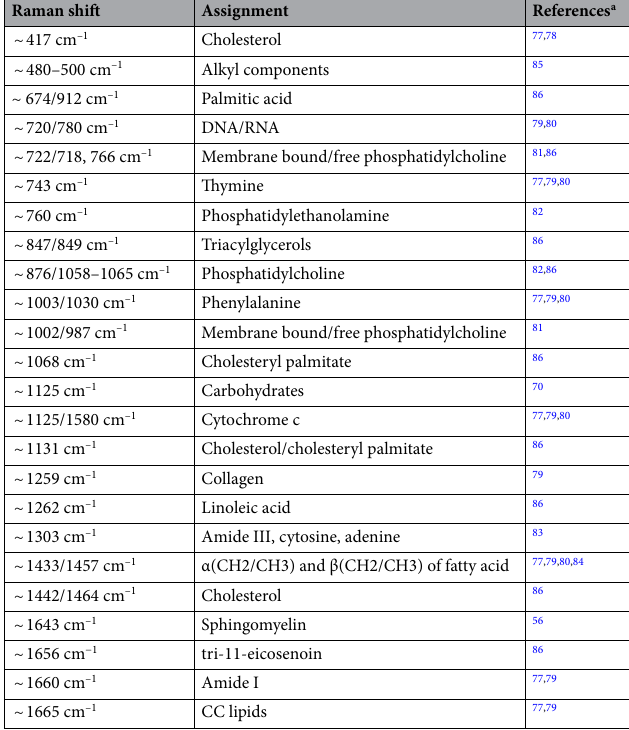
Table 1. Raman spectra wavelength with corresponding published assignments . a Slight differences in Raman shifts between measurements in this manuscript and references from the literature can be due to differences in Raman laser energy and molecular